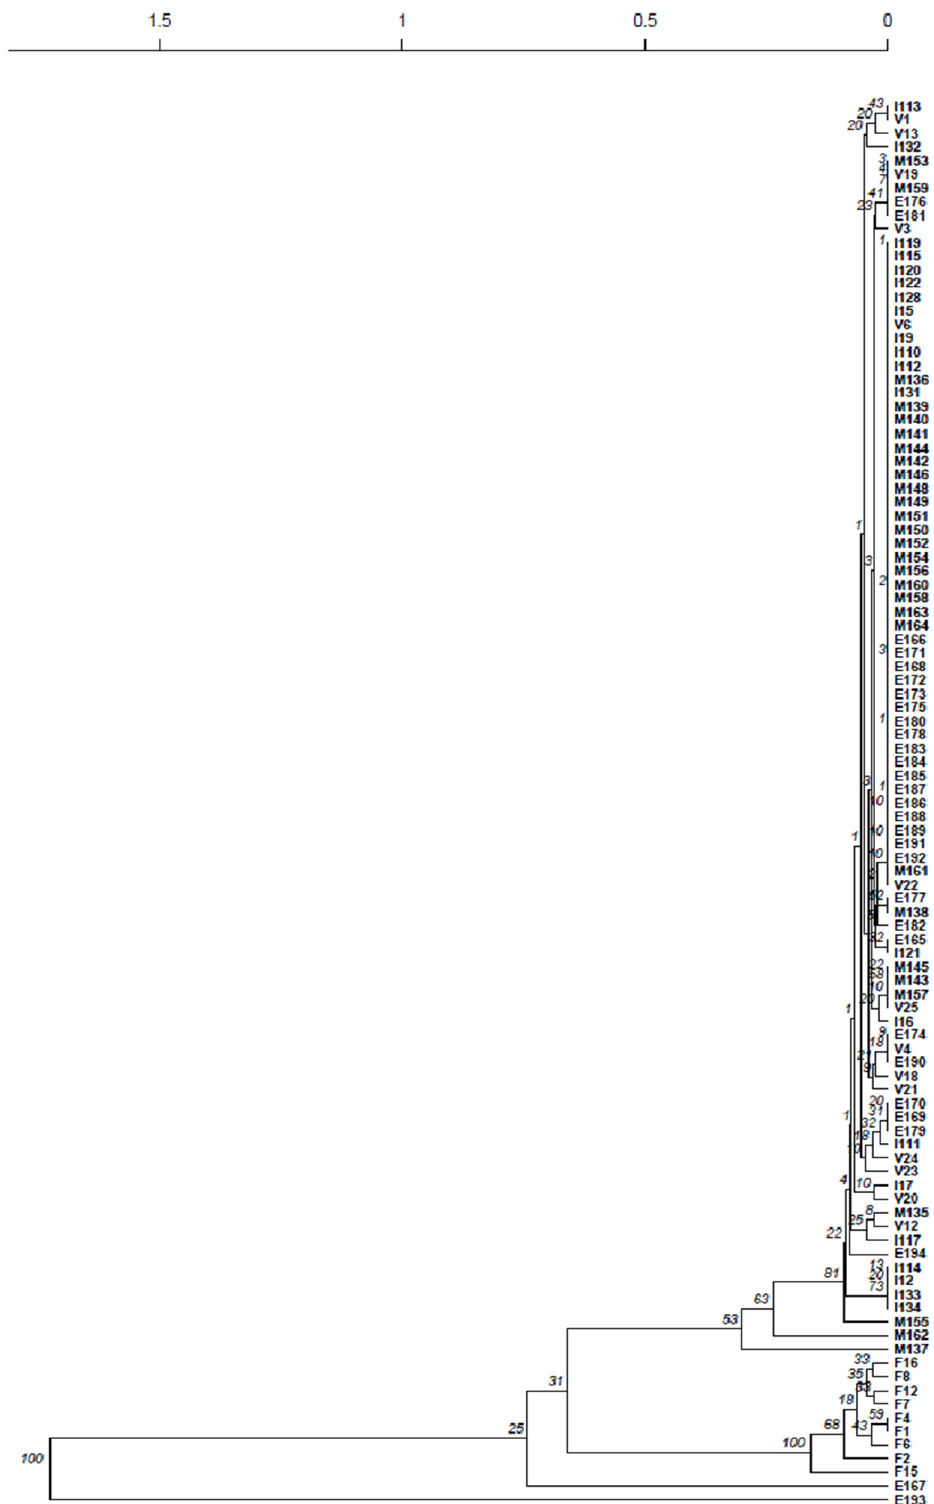
Figure 4. Dendrogram presenting the genetic distance between the isolates from Experiment 2, modality 4 and the ADY isolates, based on the microsatellite profiles. V—ADY V isolates; F—ADY F isolates; isolates from fermentation are represented by a letter; I—initial, M—middle or E—end time periods of fermentation, followed by the number of the isolate. Scale at top represents genetic distance.